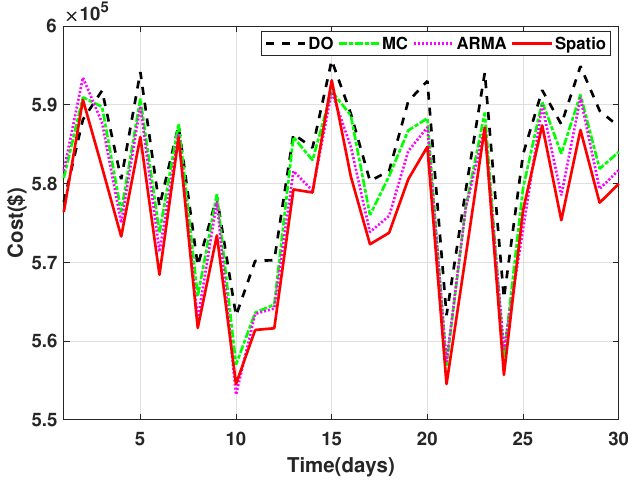
Figure 10. Dispatched ED costs.